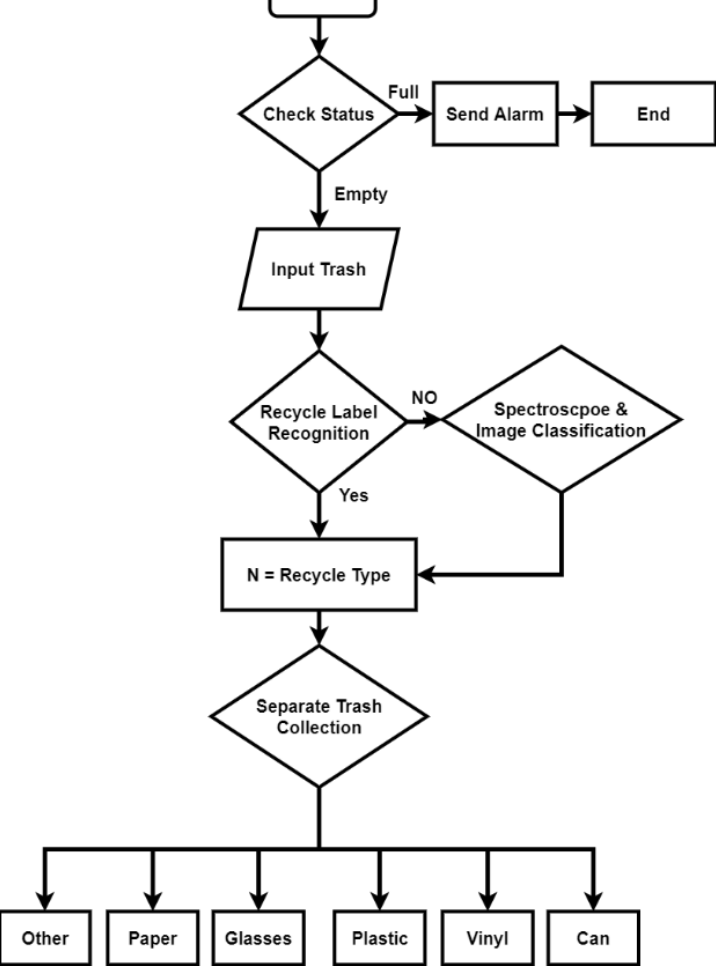
Figure 3. A flowchart of Smart Trash Bin operation processes.